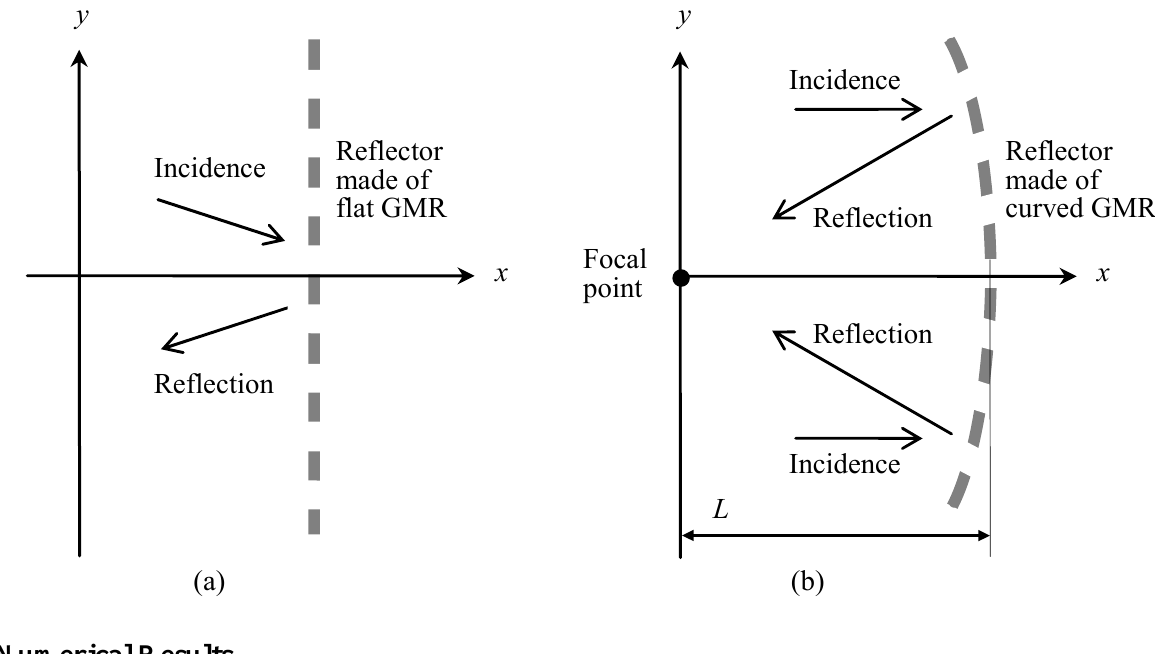
Figure 1. Illustration of (a) flat GMR reflector and (b) curved GMR